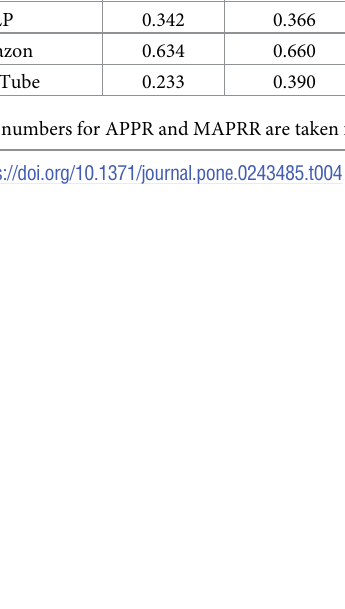
Table 4. Comparison between HG-CRD and MAPPR using undirected and directed graphs. Precision Recall F 1 APPR MAPPR HGCRD APPR MAPPR